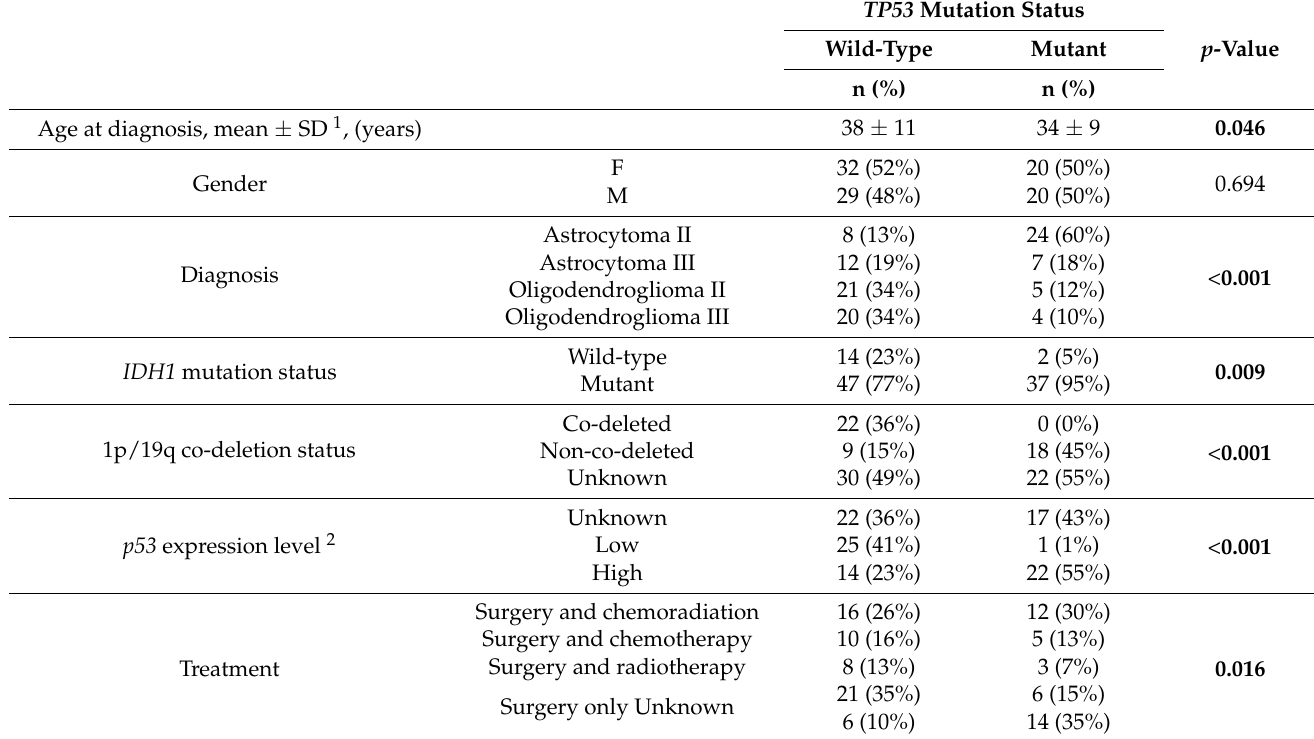
Table 3. Clinicopathological features and TP53 mutation